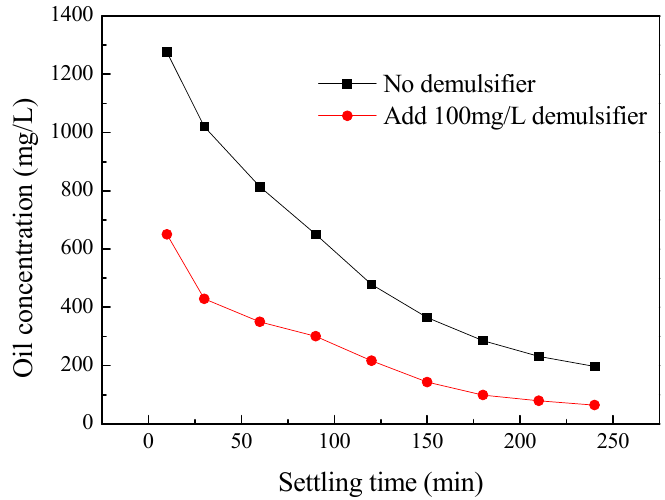
Figure 3. Influence of settling time on oil concentration.